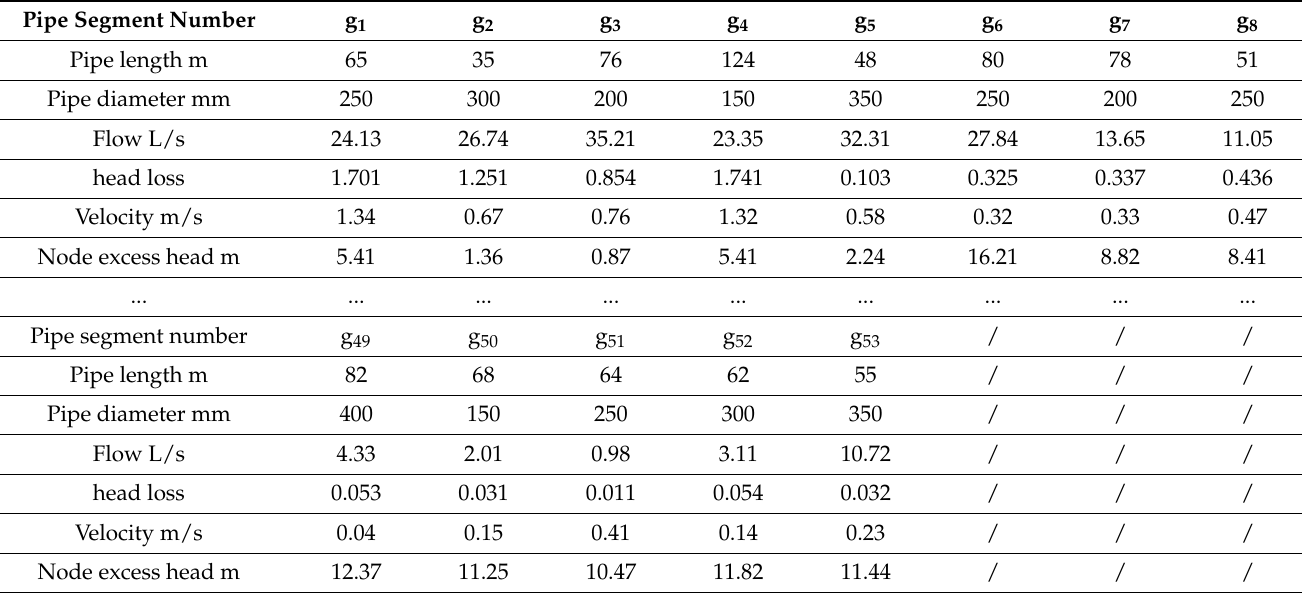
Table 1 above indicates the water calculation results. The table shows the length, pipe diameter, flow, head loss, flow rate and node excess head of each pipe section in the water supply network. Through the hydraulic check of the RWSN, the water pressure and flow rate of each node in the network meet the requirements. Therefore, based on the comprehensive consideration of economic factors and the reliability of the town, it can be concluded that the optimal node affluence head of the town’s water supply